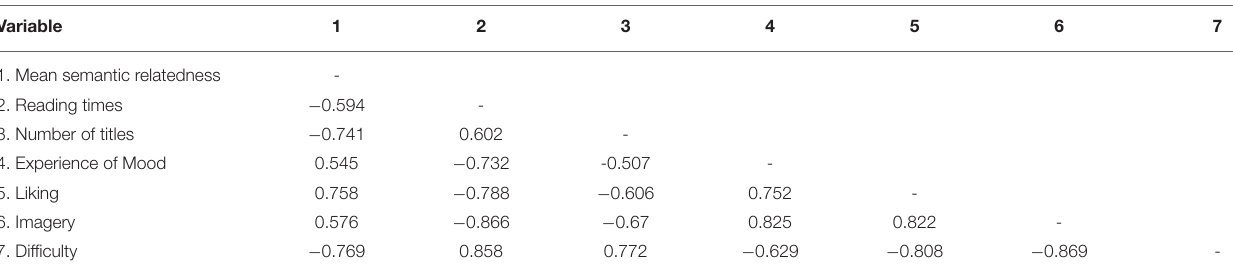
TABLE 3 | Correlation matrix of the dependent variables. Variable